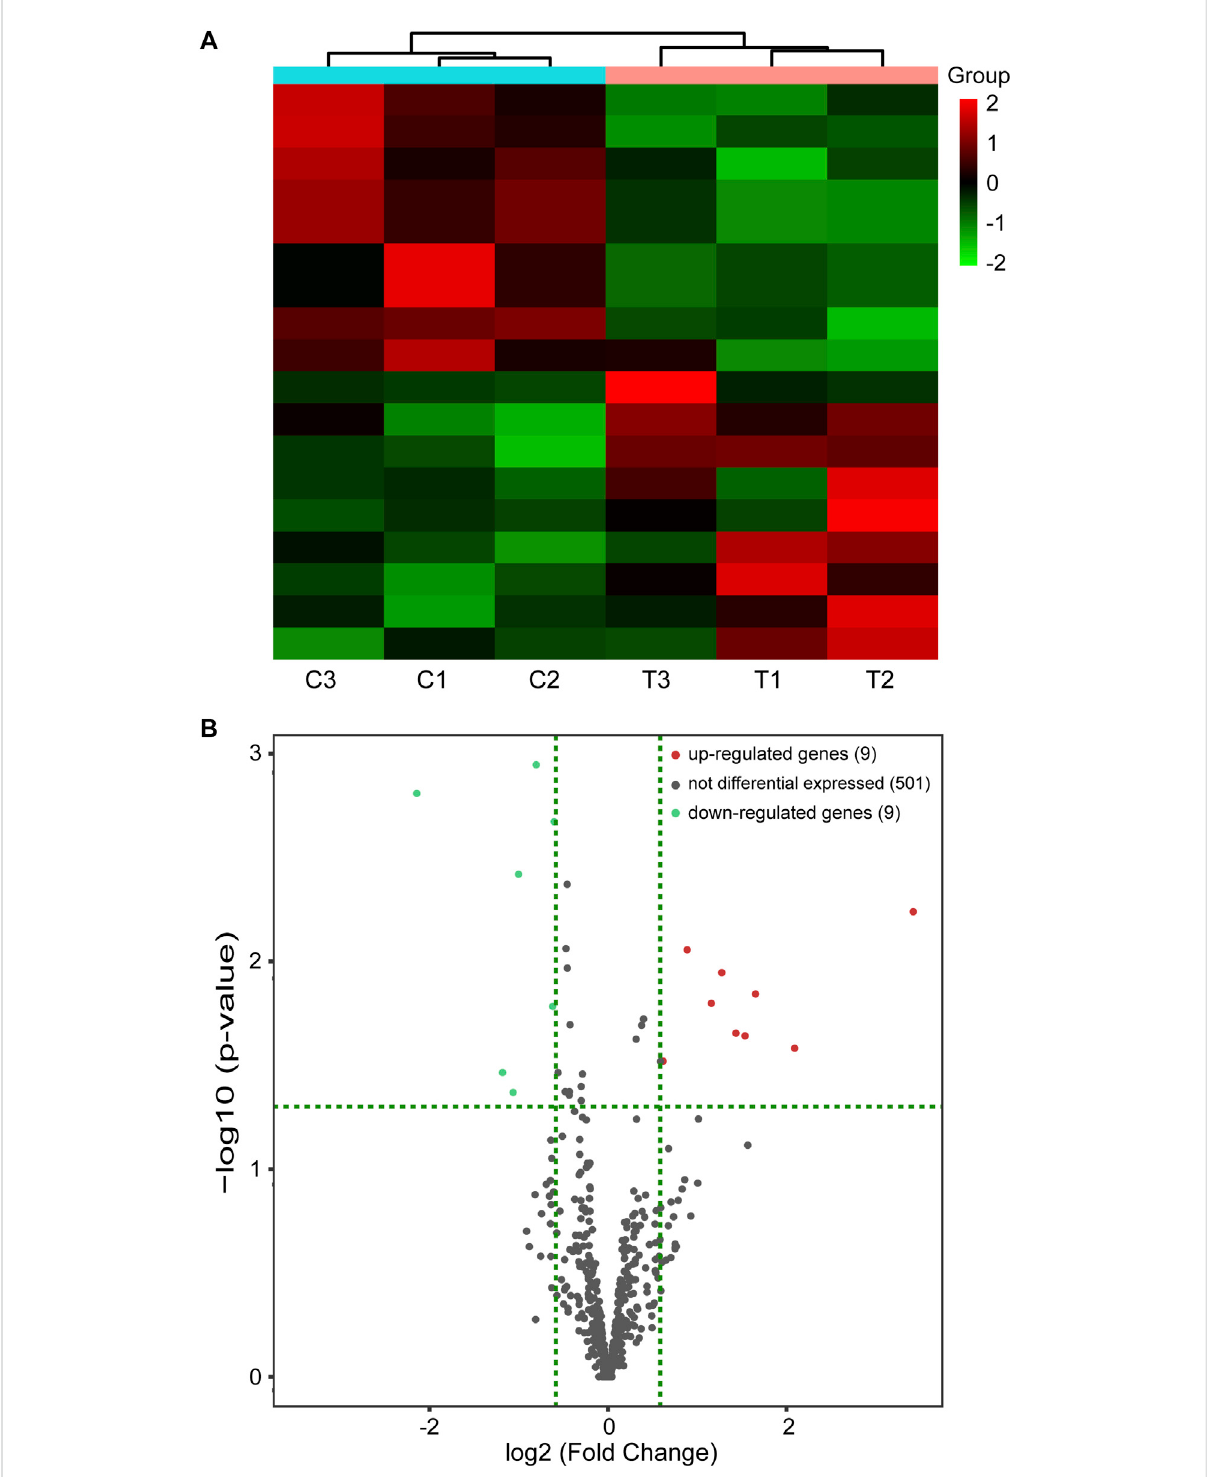
FIGURE 2 miRNA-seq data corresponding to the DEmiRs. (A) Hierarchical cluster of DEmiRs. Green represents downregulation and red represents upregulation. (B) Volcano plots. Red and blue dots represent DEmiRs. miRNA-seq, miRNA sequencing and DEmiRs, differentially expressed